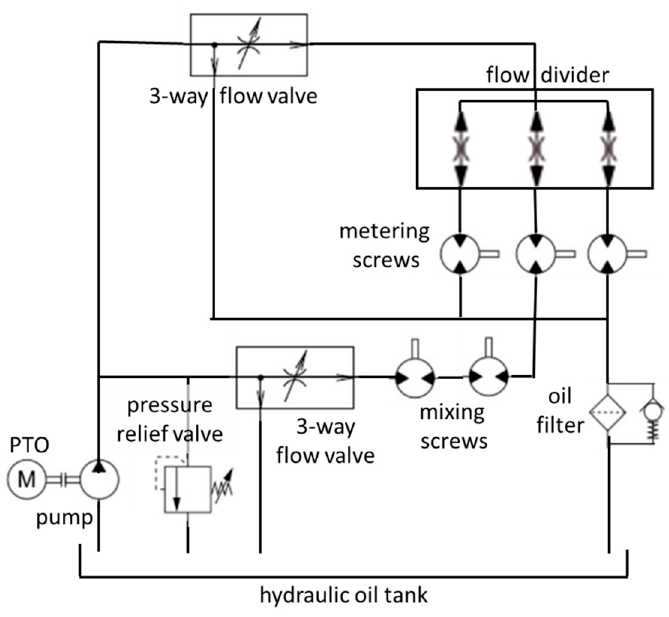
Figure 7. Scheme of the hydraulic system for compost mixing and metering. The second hydraulic circuit controls the metering by individual hydraulic motors. The required torque of 200 Nm was determined with a torque wrench. The angular speed of the motors and thus the application rate can be controlled via a manually or electrically adjustable flow valve with a downstream flow divider. The flow divider en- sures the synchronization of the three shafts by interlocking mechanical connection. 3.2. Technology Evaluation 3.2.1. Dosing Quality Figure 8 shows the throughput of compost determined at different angular speeds of the metering augers. The linear regression has a quality of almost 1.0. The CV of 0.051 is rated ‘very good’ based on the DLG test standard [23]. Figure 8. Mass flow versus angular speed of the metering augers and dosing quality rated by the coefficient of variation according to DLG test framework.